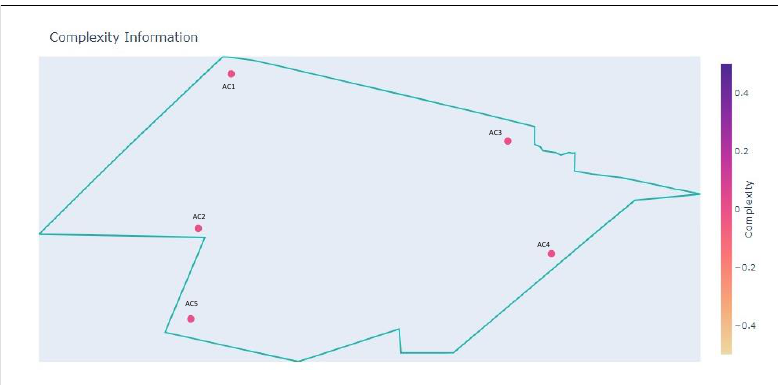
Figure 6. Initial state of scenario. The provided information should affect the decision of the ATC by considering three different